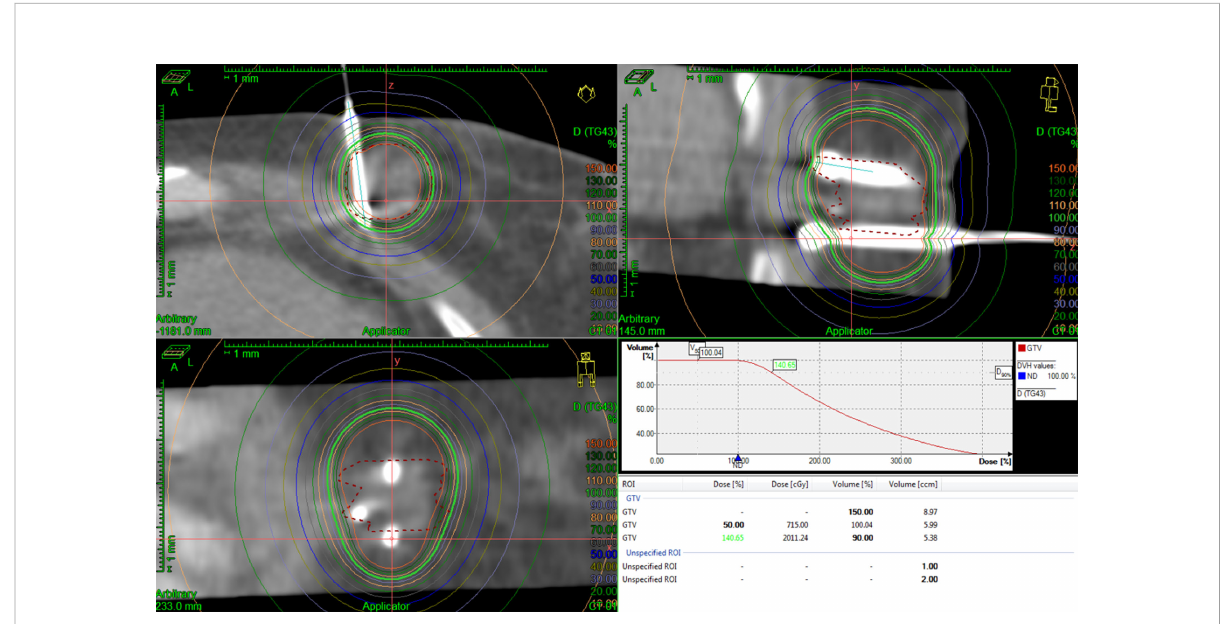
FIGURE 5 Three-dimensional dose distribution and DVH of the second fraction of IB.